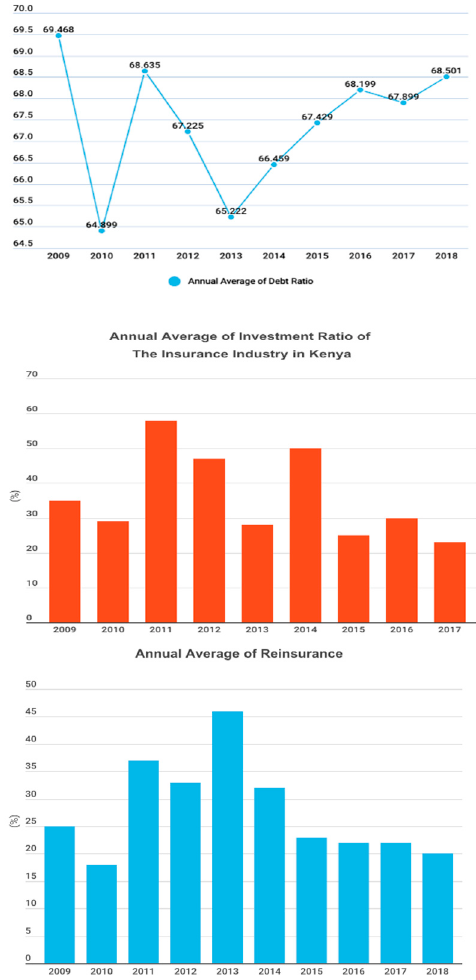
Figure 2. Trends in Debt Ratio, Investment Ratio and Reinsurance Ratios for both General and Life Insurers, 2009–2018.